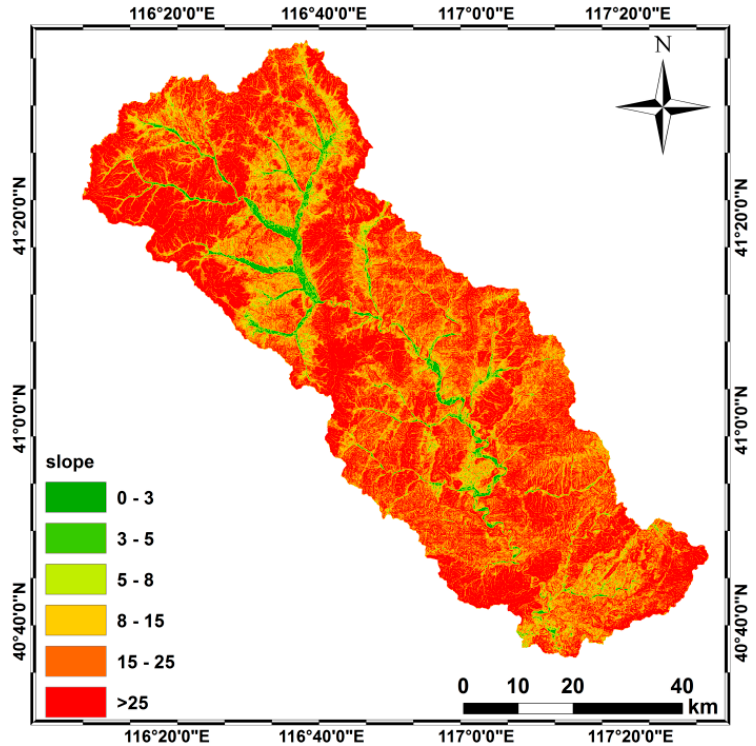
Figure 3. Slope classification of the upper watershed of the Miyun reservoir.